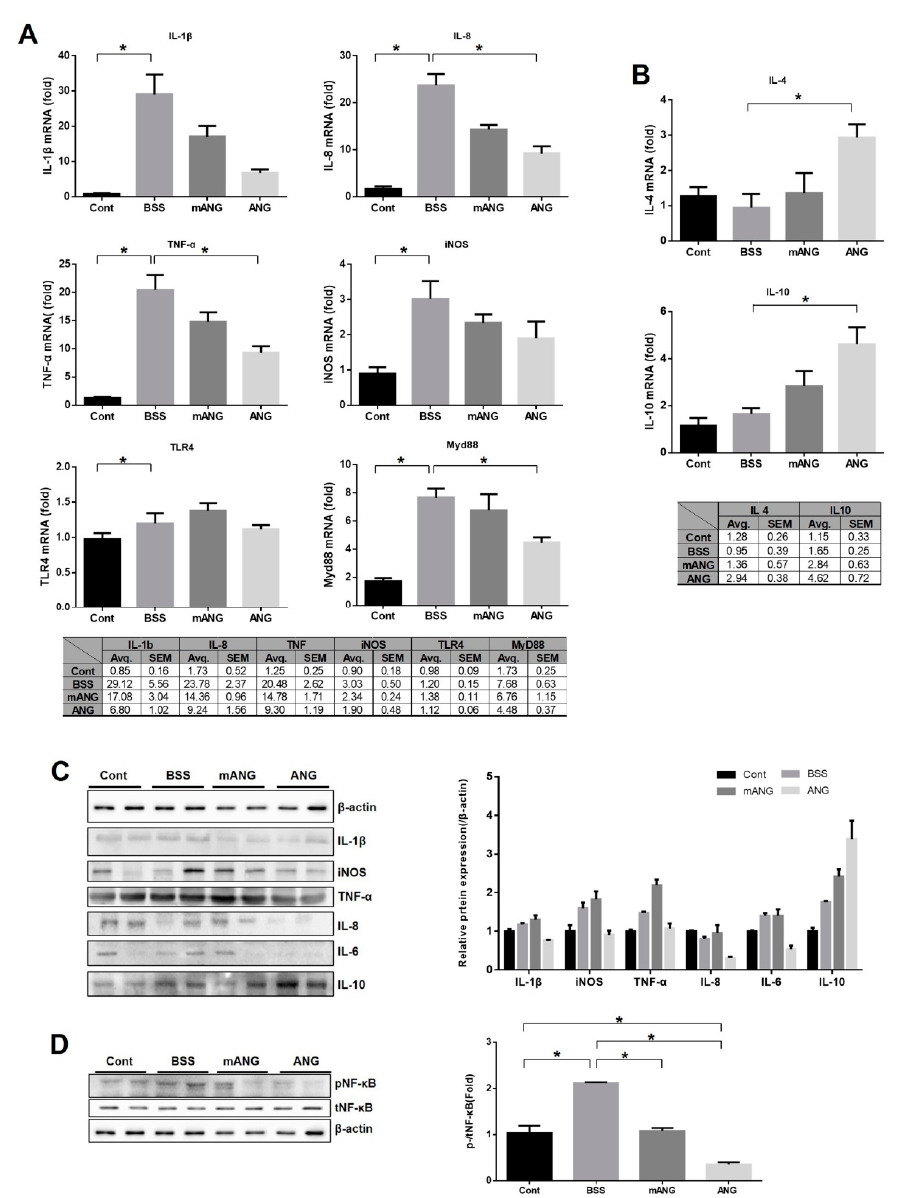
Figure 3. Real ‐ time qRT ‐ PCR analyses and Western blot of proinflammatory and anti ‐ inflammatory cytokines, TLR4, and Myd88 in LPS induced rat eye tissue with ANG or mANG or without treatment. ( A ) The increased relative mRNA levels of IL ‐ 1 β , IL ‐ 8, TNF ‐α , iNOS, and Myd88 were diminished by ANG treatment. However, TLR4 was not reduced upon ANG treatment. Treatment with mANG had no significant effect on reducing the mRNA expressions. ( B ) The relative mRNA levels of anti ‐ inflammatory cytokines IL ‐ 4 and IL ‐ 10 were increased by ANG treatment. Treatment with mANG had no significant effect on increasing them; values represent the mean ± standard error (* p < 0.05, Avg = mean). ( C ) Western blot analyses showed ANG treatment reduced iNOS, TNF ‐α , and IL ‐ 8 protein expressions in LPS induced EIU eyes. ( D ) After ANG treatment, nuclear translocation of NF ‐ κ B induced by LPS was decreased as seen by reduced pNF ‐κ B expression and decreased p ‐ /tNF ‐κ B. The cytosolic NF ‐κ B was not affected by either ANG or mANG ( n = 5 rats per group).